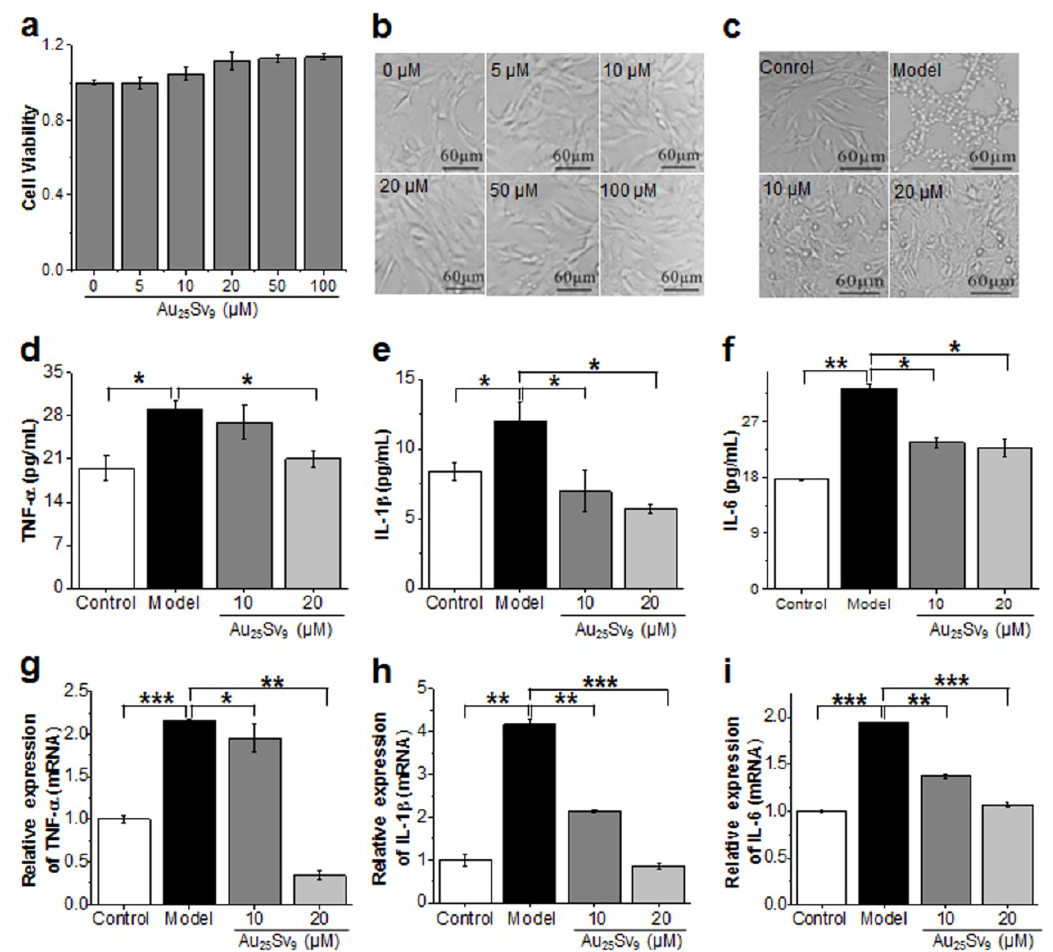
Figure 2. E ff ects of Au 25 Sv 9 on HBZY-1 cell viability and inflammatory cytokine expression. ( a ) Cell viability of HBZY-1 cells after incubation with di ff erent doses of Au 25 Sv 9 for 24 h. The data was presented as the mean of triplicate experiments. ( b ) Cell morphology of HBZY-1 cells after incubation with di ff erent doses of Au 25 Sv 9 for 24 h. The representative images were shown. ( c ) Cell morphological changes of HBZY-1 cells after 0.1 µ g / mL LPS (lipopolysaccharide) stimulation with or without Au 25 Sv 9 pretreatment for 24 h. The representative images were shown. ( d – f ) The e ff ect of Au 25 Sv 9 on LPS-induced TNF- α (tumor necrosis factor alpha), IL-1 β (interleukin-1 beta) and IL-6 (interleukin-6) secretion in the supernatant of HBZY-1 cells after 24 h incubation. Results were expressed as the mean of three repeated experiments ± standard deviation (SD), * P < 0.05, ** P < 0.01. ( g – i ) The e ff ect of Au 25 Sv 9 on the LPS-induced transcription of TNF- α , IL-1 β and IL-6 in HBZY-1 cells after 12 h incubation were detected by RT-qPCR (real-time quantitative PCR). GAPDH was used to normalize the data. Data are presented as the mean of three repeated experiments ± SD, * P < 0.05, ** P < 0.01, *** P <